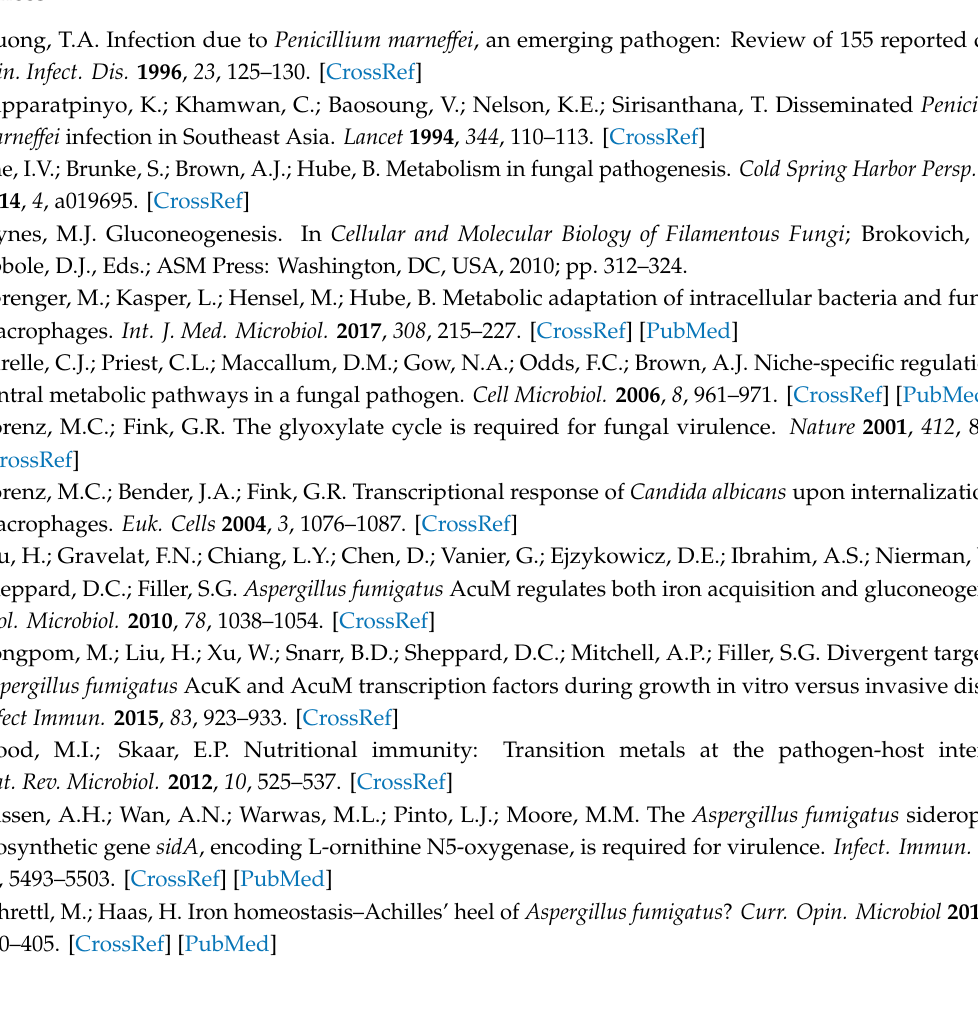
Figure S1. Analysis of the acuM and acuK genes in Talaromyces marne ff ei